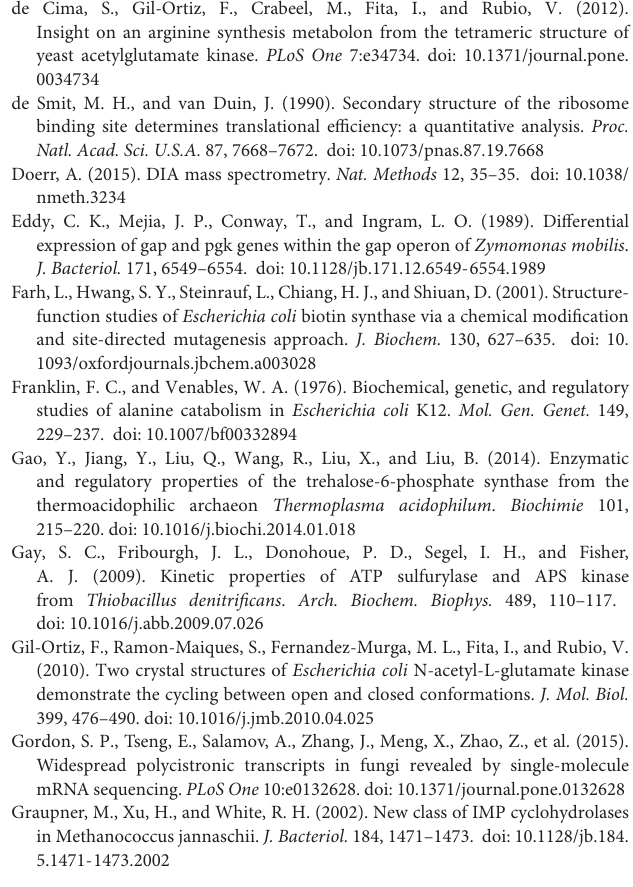
FIGURE S3 | Length- and functional-dependence of operon stoichiometry control compare to randomized data. (A–E) Distribution among “Complex,” “Complex_random,” “Pathway,” and “Pathway_random” groups in BW25113. (F–J) Distribution among “Complex,” “Complex_random,” “Pathway,” “Pathway_random” groups in MG1655. In most cases, the CV in “Complex” and “Pathway” groups were lower than corresponding “Complex_random” and “Pathway_random” groups in both strains, indicating real robust signals but not statistical artifacts in operons present in E. coli. FIGURE S4 | Length dependence of the stoichiometry control at RNA and protein levels. Same figure in MG1655 strain, comparable to the Figure 4A . FIGURE S5 | Distribution of protein half-life CV in “Complex” and “Pathway” operons. FIGURE S6 | Pathways in Figure 5 . TABLE S1 | DIA MS/MS isolation windows table. TABLE S2 | Spectral library used in HRM-MS analysis. TABLE S3 | Protein abundances and properties used in this analysis. TABLE S4 | P -value of Mann–Whitney U test between complex and pathway operons shown in Figure 3C . TABLE S5 | P -value of gene ontology (GO) overrepresentation of the operons with lower and higher CV groups shown in Figures 3D,E . SUPPLEMENTARY SCRIPTS | The python scripts used in this